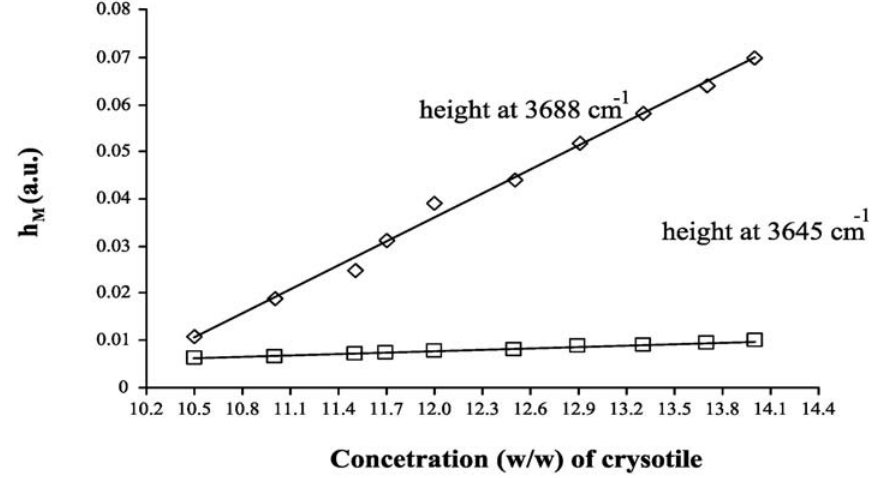
Figure 4. Linear Calibration Curve Method (LCM) linear curves for